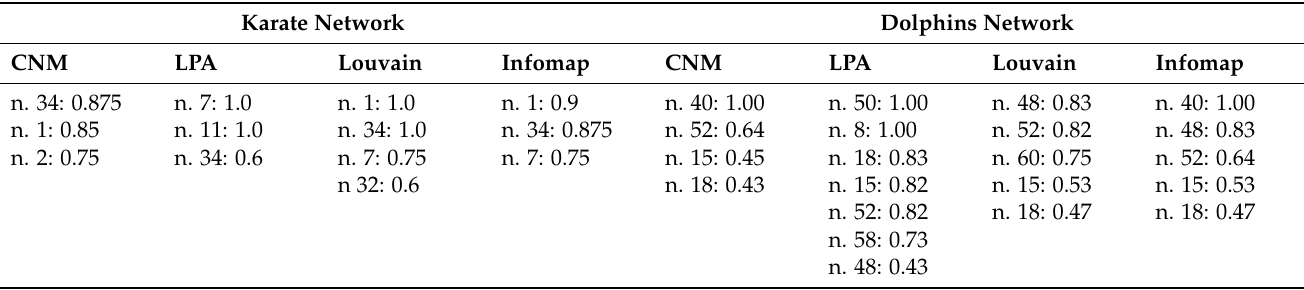
Table 5. Hub dominant nodes of each community (node: HD score).